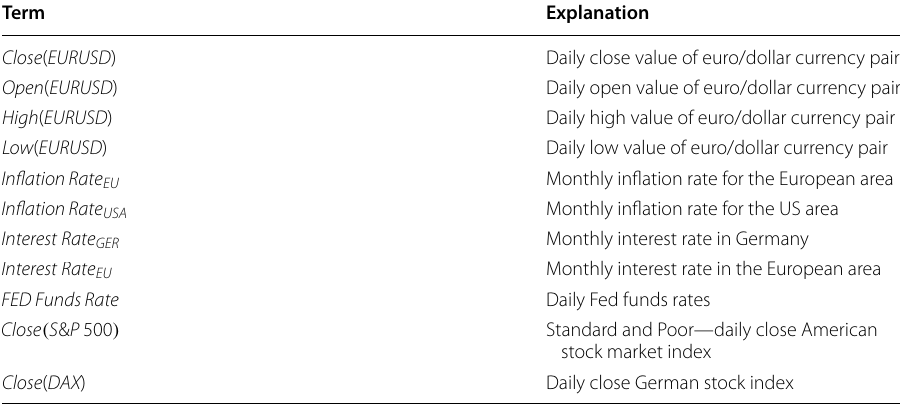
Table 1 Macroeconomic data and the currency pair used in the data set Term Explanation Close ( EURUSD ) Open ( EURUSD ) High ( EURUSD